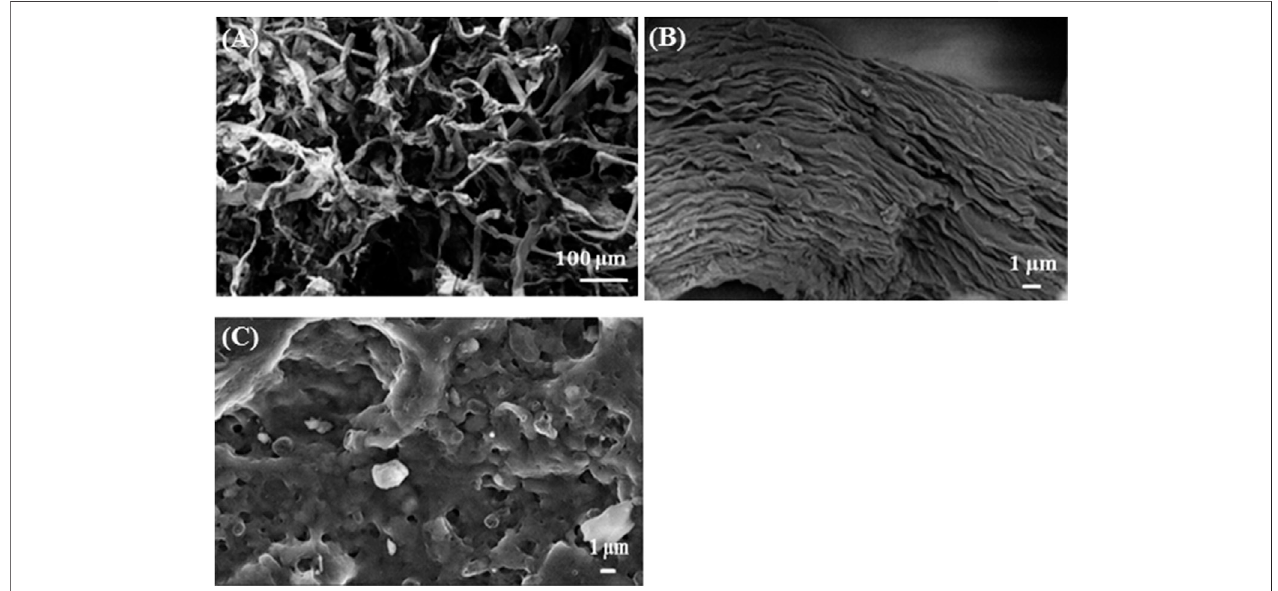
FIGURE 1 | Scanning electron microscope (SEM) images of: (A) BK at low magni fi cation, (B) BK at higher magni fi cation, and (C) TBK.